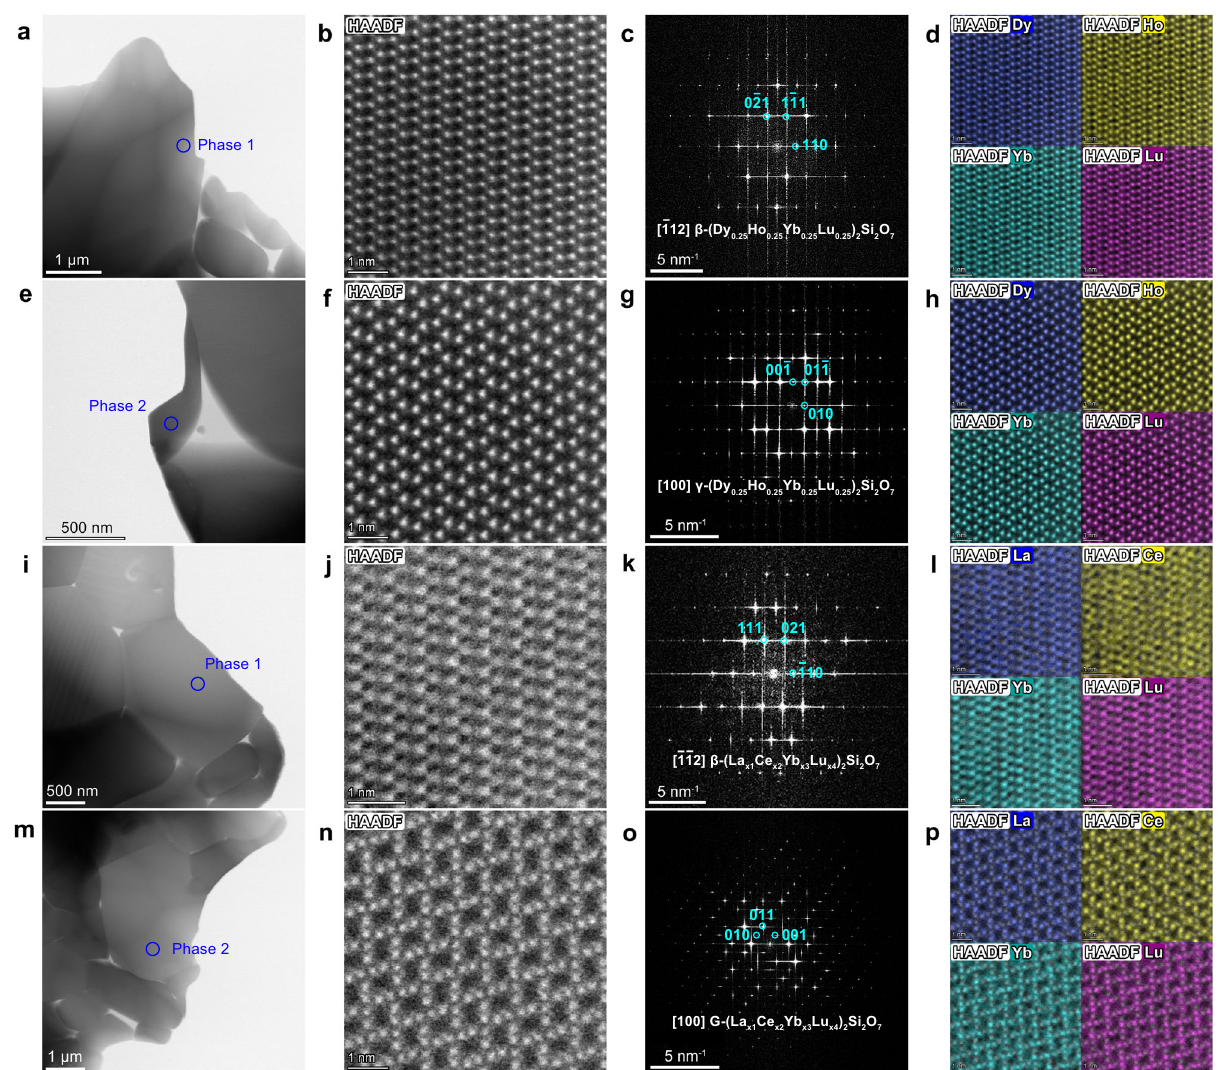
Fig. 3 | TEM characterization results of (Dy 0.25 Ho 0.25 Yb 0.25 Lu 0.25 ) 2 Si 2 O 7 and j , n The HAADF-STEM images of phase 1 and phase 2 in (La x1 Ce x2 Yb x3 Lu x4 ) 2 (La x1 Ce x2 Yb x3 Lu x4 ) 2 Si 2 O 7 bulksamples.a , e Thebright- fi eldimagesofphase1and Si 2 O 7 . k , o The Fast Fourier transform (FFT) of the HAADF-STEM images of phase 2 in (Dy 0.25 Ho 0.25 Yb 0.25 Lu 0.25 ) 2 Si 2 O 7 sample. b , f The Scanning transmission (La x1 Ce x2 Yb x3 Lu x4 ) 2 Si 2 O 7 in j , n , taken in the [ (cid:1) 1 (cid:1) 12] zone axis and [100] zone axis, electronmicroscopichigh-angleannulardark- fi eld(HAADF-STEM)imagesofphase respectively. l , p The corresponding atomic-resolution EDS elemental maps 1 and phase 2 in (Dy 0.25 Ho 0.25 Yb 0.25 Lu 0.25 ) 2 Si 2 O 7 . c , g The Fast Fourier transform for La, Ce, Yb and Lu of β -(La x1 Ce x2 Yb x3 Lu x4 ) 2 Si 2 O 7 and G-(La x1 Ce x2 Yb x3 Lu x4 ) 2 Si 2 O 7 . The blue circles in a , e , i , and m locate the observed grains in (FFT) of the HAADF-STEM images of (Dy 0.25 Ho 0.25 Yb 0.25 Lu 0.25 ) 2 Si 2 O 7 in b and f , taken in the [ (cid:1) 112] zone axis and [100] zone axis, respectively. d , h The corre- (Dy 0.25 Ho 0.25 Yb 0.25 Lu 0.25 ) 2 Si 2 O 7 and (La x1 Ce x2 Yb x3 Lu x4 ) 2 Si 2 O 7 samples that corre- spond to different phases (marked as “ Phase 1 ” or “ Phase 2 ” ). The cyan circles and sponding atomic-resolution EDS elemental maps for Dy, Ho, Yb and Lu of γ -(Dy β -(Dy numbers in c , g , k , and o denote the Miller indices of corresponding 0.25 Ho 0.25 Yb 0.25 Lu 0.25 ) 2 Si 2 O 7 and 0.25 Ho 0.25 Yb 0.25 Lu 0.25 ) 2 Si 2 O 7 . i , m The bright- fi eld images of phase 1 and phase 2 in (La x1 Ce x2 Yb x3 Lu x4 ) 2 Si 2 O 7 sample.